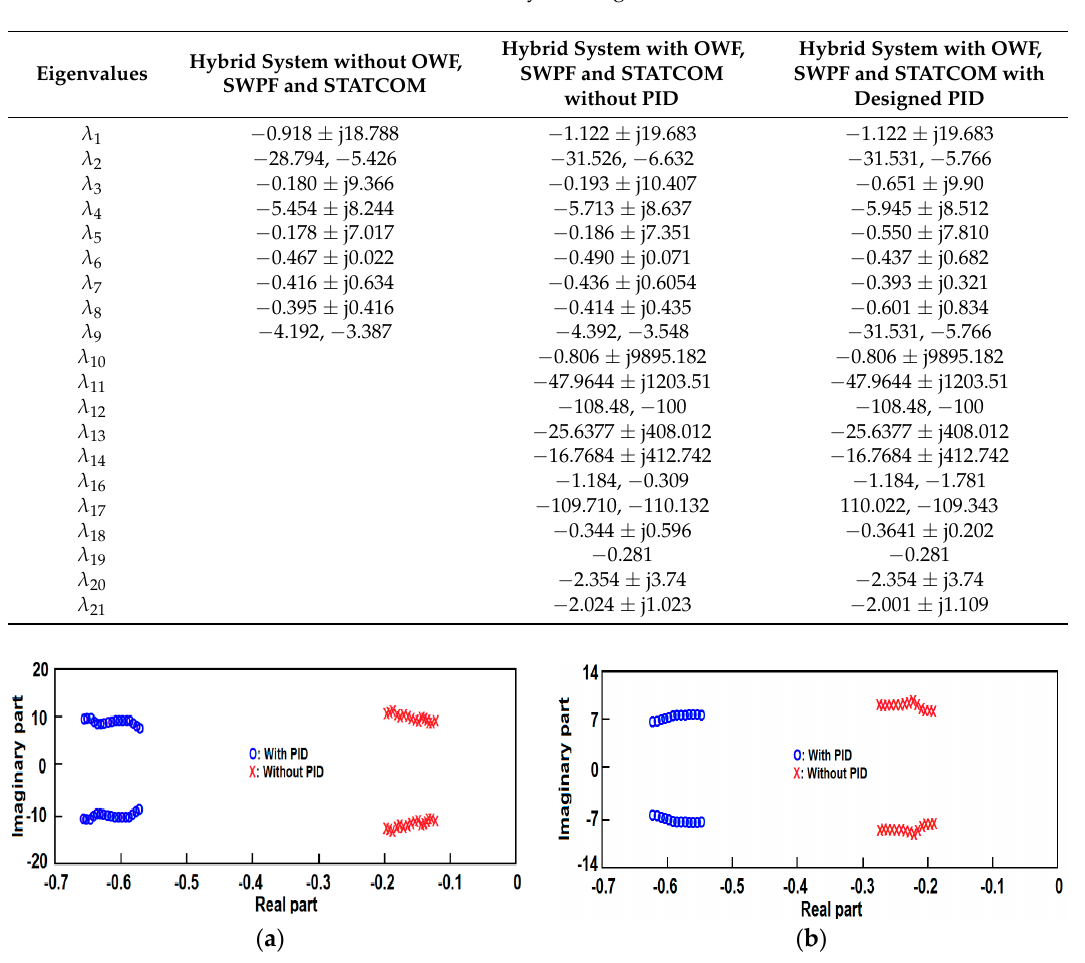
Table 1. The analysis of eigenvalues.